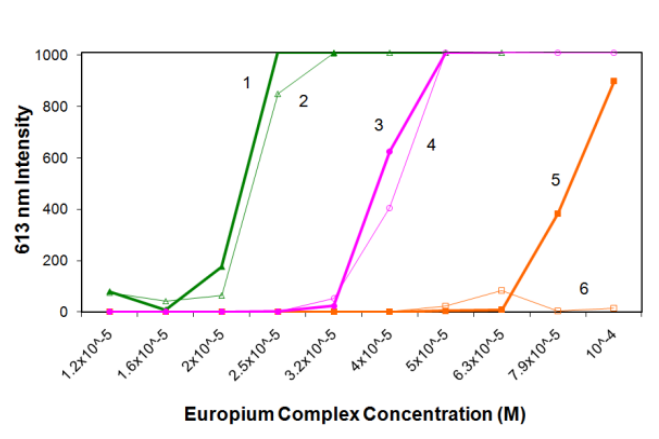
FIGURE 2 . A 613-nm emission intensity in seawater of (1) Eu/TTA/OP with NG (10 –3 M ), (2) Eu/TTA/OP without NG, (3) Eu/OP/TTA with NG (10 –3 M ), (4) Eu/OP/TTA without NG, (5) Eu/TTA with NG (10 –3 M ), and (6) Eu/TTA without NG. The reagent solvent (methanol) comprised 5% of the solution.